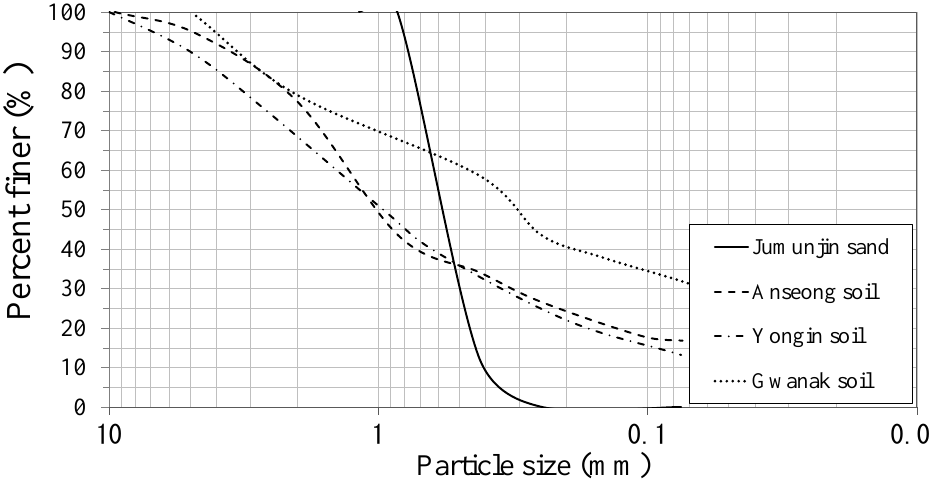
Figure 4. Particle size distribution of the test specimens.